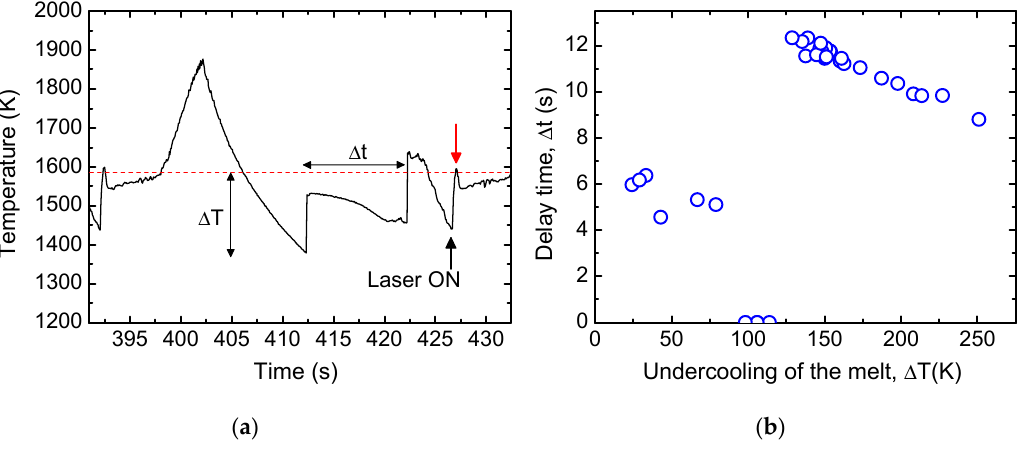
Figure 1. ( a ) Representative time-temperature profile of a CoSi-62 at. % alloy processed in the electrostatic levitator (ESL). The liquidus temperature (marked by a red dotted line) was determined based on the Co-Si phase diagram. ( b ) Changes of delay time as a function of undercooling of the melt. The delay time shows three distinct regions of behavior.